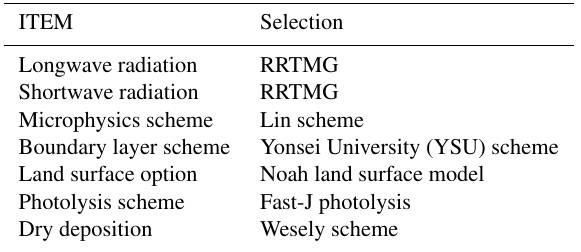
Table 1. Major model configuration options used in the